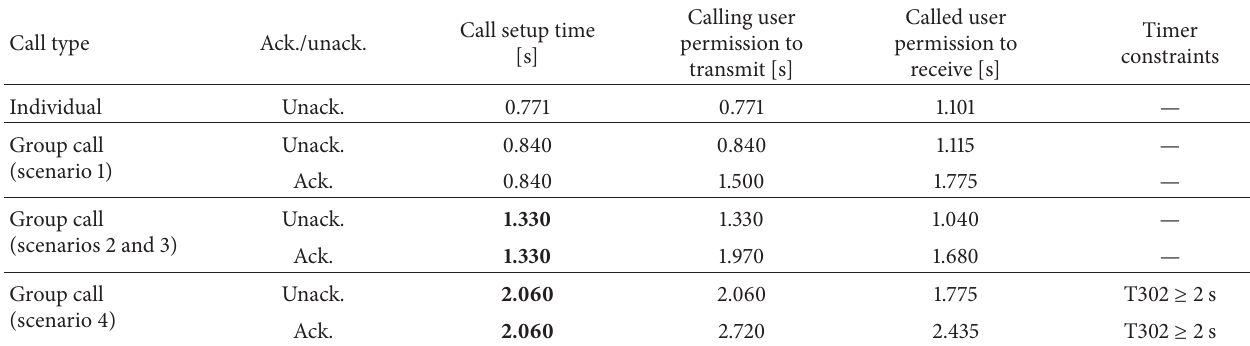
Table 2: TETRA call setup times with ISI via